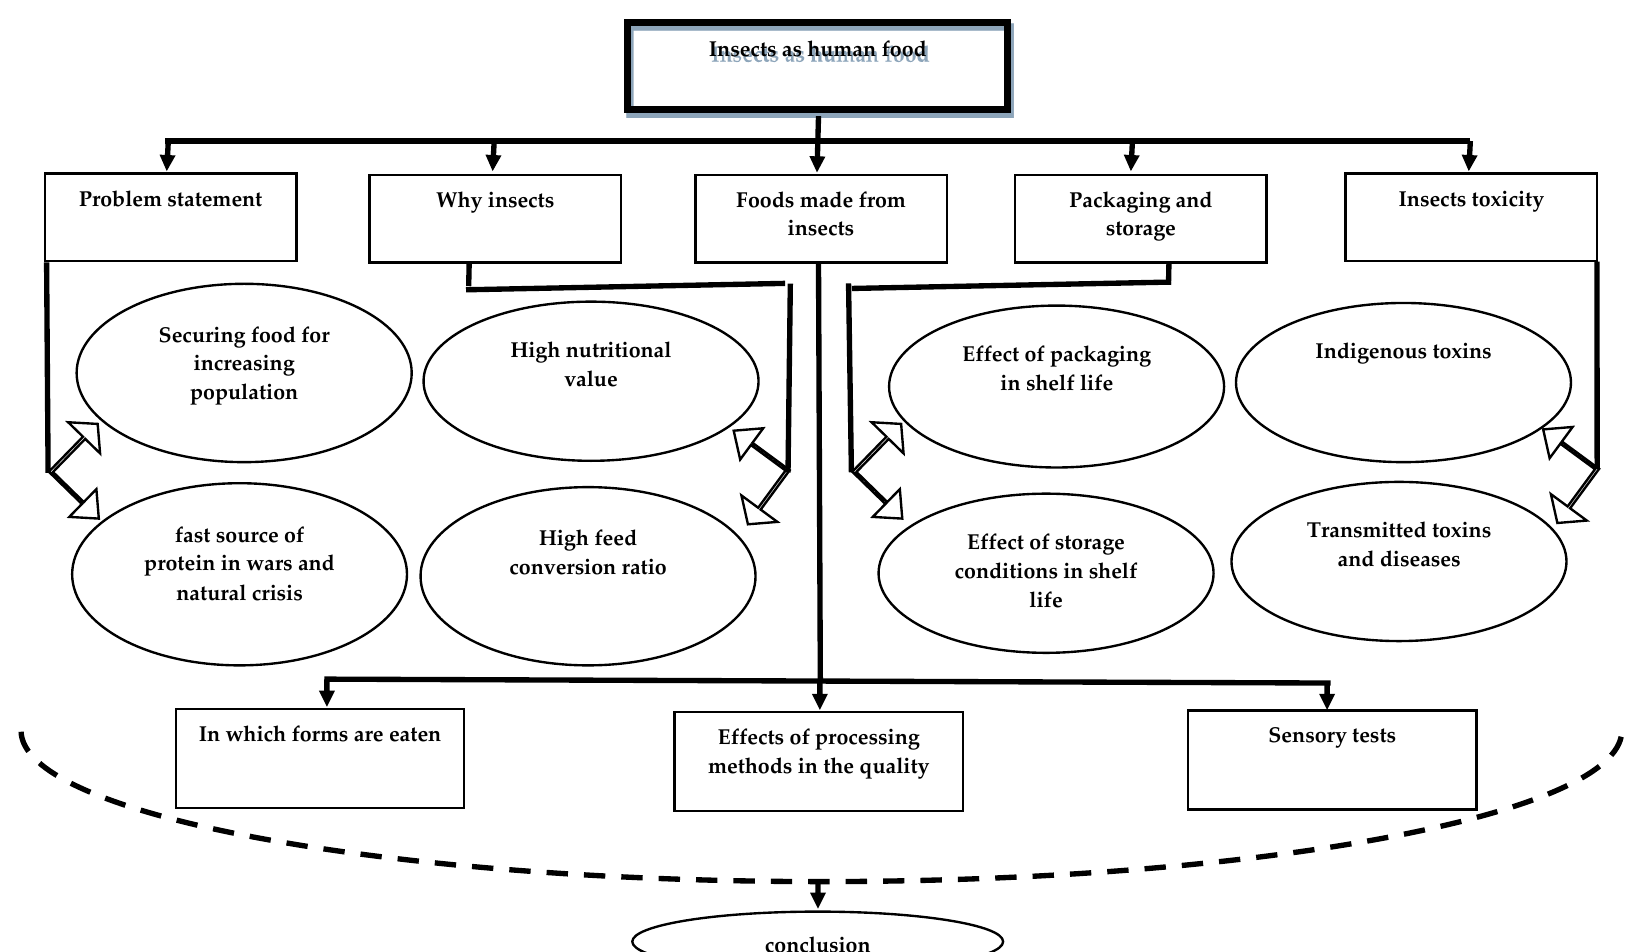
Figure 1. Flowchart of insects as human food literature review .